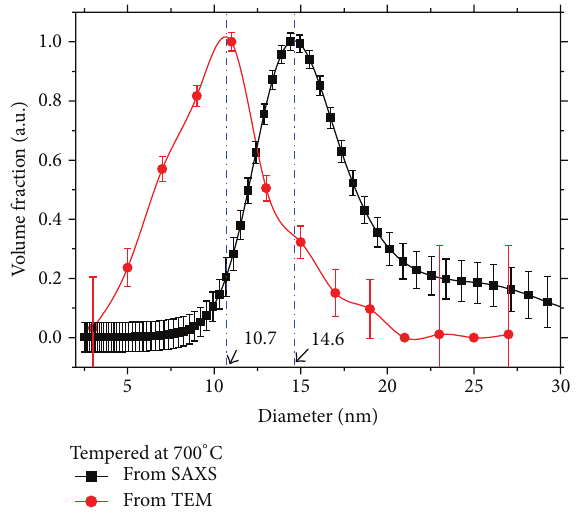
Figure6:SizedistributionofHebubblesfromTEMimages(Figures 5(a) and 5(b)) and SAXS measurement.